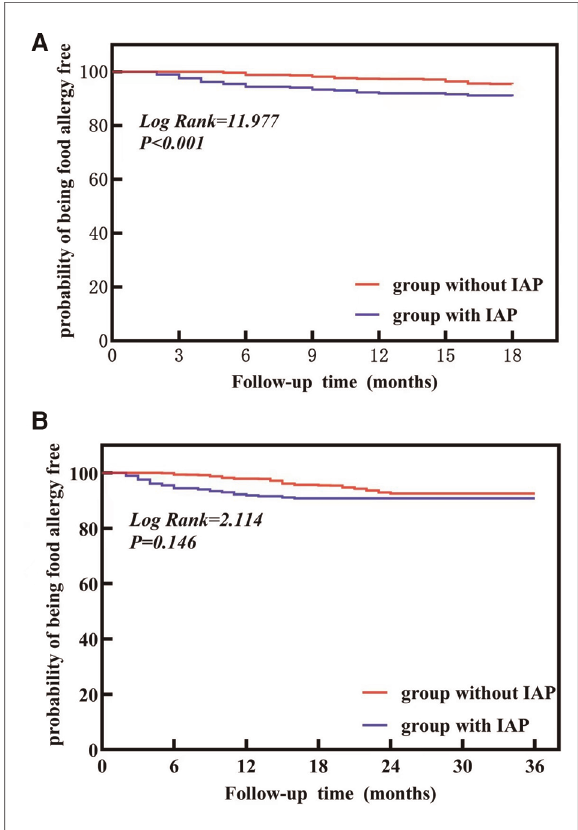
FIGURE 2 The survival curve for the development of food allergy according to Intrapartum Antibiotic Prophylaxis (IAP) ( A ) represents a follow-up of 18 months. ( B ) represents followed-up to 3 years old. IAP, intrapartum antibiotic